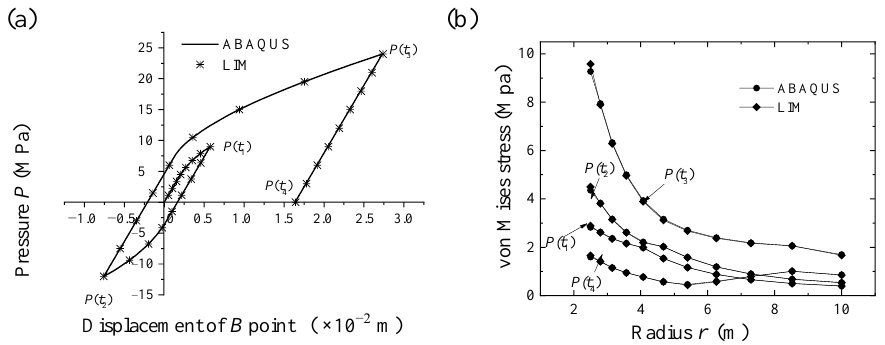
Figure 4. Comparison of LIM and ABAQUS: ( a ) load-displacement diagram and ( b ) von Mises stress along radius.